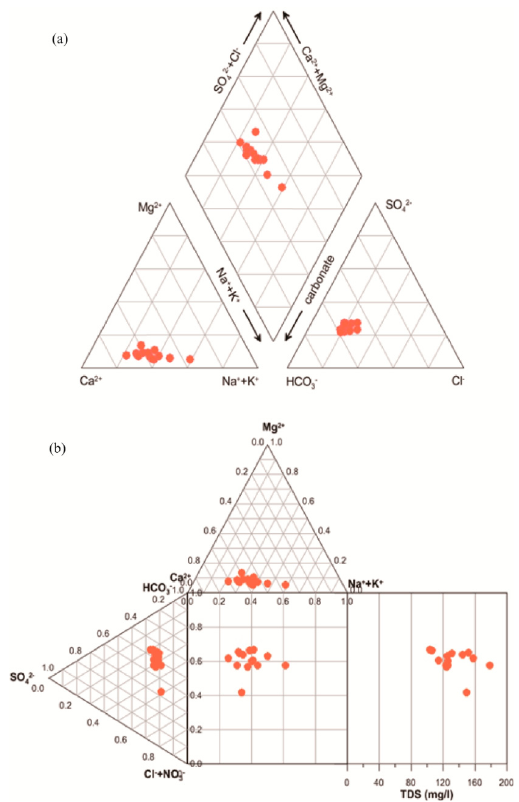
Figure 3. ( a ) Piper and ( b ) Durov diagrams showing the hydrogeochemical evolution of